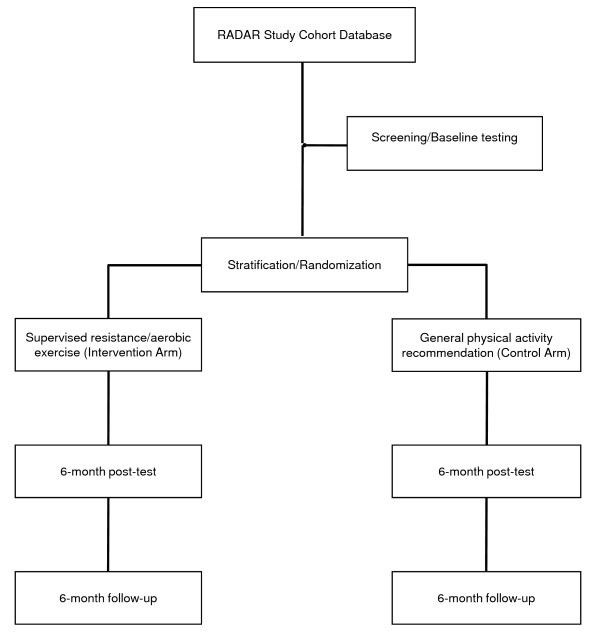
CONSORT diagram.